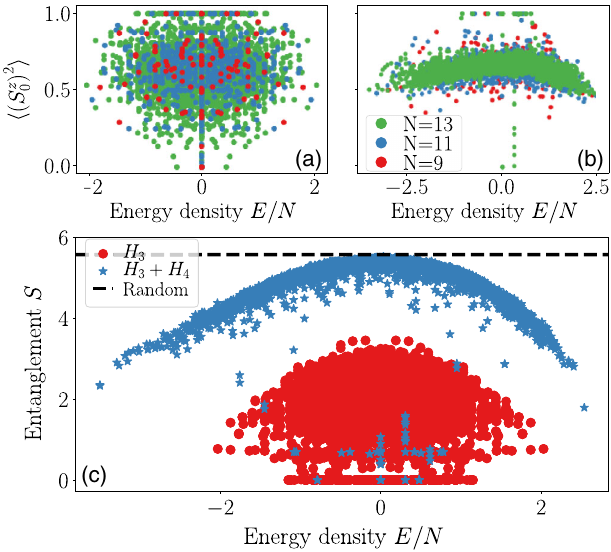
FIG. 8. Ergodicity breaking due to strong and weak fragmen- tation. Expectation value of the local operator ð S z 0 Þ 2 for eigen- states within the ð q; p Þ ¼ ð 0 ; 0 Þ sector as a function of the energy for different system sizes. (a) Strong fragmentation: For the minimal Hamiltonian H 3 , the width of the distribution does not decrease with N , violating the eigenstate thermalization hypoth- esis. (b) Weak fragmentation: For H 3 þ H 4 , most eigenstates appear thermal, and the bulk of the distribution narrows with N , but outliers remain, showing that the system obeys the weak, but not strong, ETH. (c) Half-chain entanglement entropy of the eigenstates for H 3 (red dots) and H 3 þ H 4 (blue stars), for N ¼ 13 , leads to the same conclusion. The black dashed line shows the entanglement entropy of a random state in the ð q; p Þ ¼ ð 0 ; 0 Þ sector.